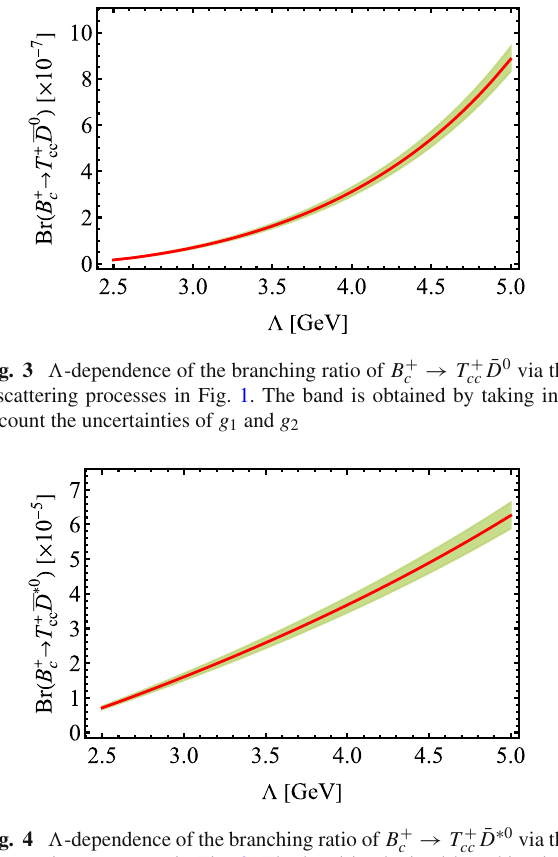
Fig. 4 (cid:6) -dependence of the branching ratio of B + c → T + cc ¯ D ∗ 0 via the rescattering processes in Fig. 2. The band is obtained by taking into account the uncertainties of g 1 and g 2